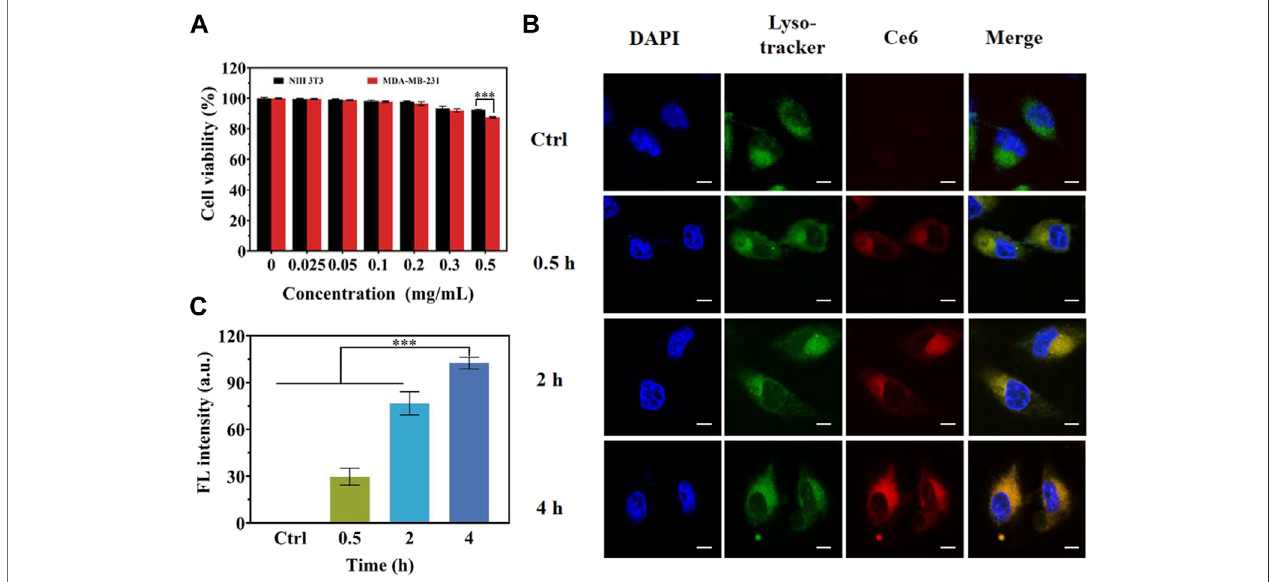
FIGURE 4 | In vitro cytotoxicity and cellular uptake behavior of MCPM NPs. (A) In vitro cytotoxicity assay of MCPM NPs in NIH3T3 and MDA-MB-231 cells. (B) CLSM images ofMDA-MB-231 cells withMCPMNP treatment for different incubation durations. (C) Pro fi les ofrespective fl uorescence intensities forthe MDA-MB-231 cells in (B) . *** p < 0.001.